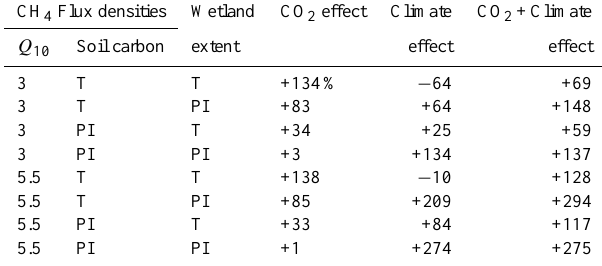
Table 3. CO 2 alone, climate alone and combined effect on dif- ference in global wetland CH 4 emissions between 2099–2090 and 1860–1869. Results are done for simulations with a constant T mean . CH 4 emissions with pre-industrial soil carbon (last line of the table) correspond to a sensitivity test done a posteriori (cf. discussion). Results are done in percent of global pre-industrial emissions. In our study, CO 2 effect and climate alone are considered independent and are derived from only 3 simulations (cf. Table 1) thus last row of the Table 3 is the sum of the two previous